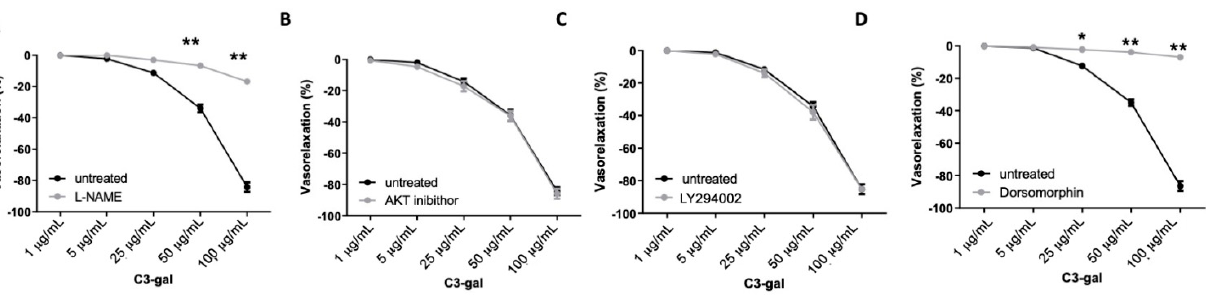
Figure 5. ( A – D ) Vascular response of phenylephrine-precontracted mice mesenteric arteries to increasing doses of cyanidin-3-galactoside ( A ) in presence of L-NAME ( N = 5), ( B ) in presence of Akt inhibitor ( N = 5), ( C ) in presence of PI3K inhibitor LY294002 ( N = 5), ( D ) or in presence of dorsomorphin ( N = 5), a selective AMPK inhibitor. * p < 0.05; ** p < 0.01.